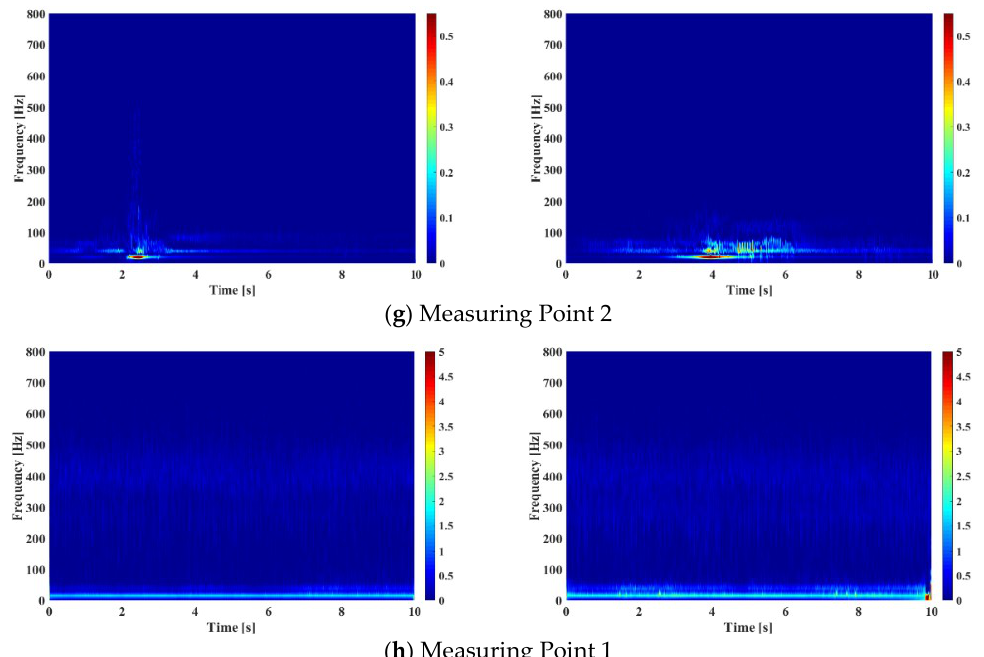
Figure 12. Hilbert energy spectrum of each measuring point in the first pass (left) and the eighth pass (right). Appl. Sci. 2019 , 9 , x FOR PEER REVIEW